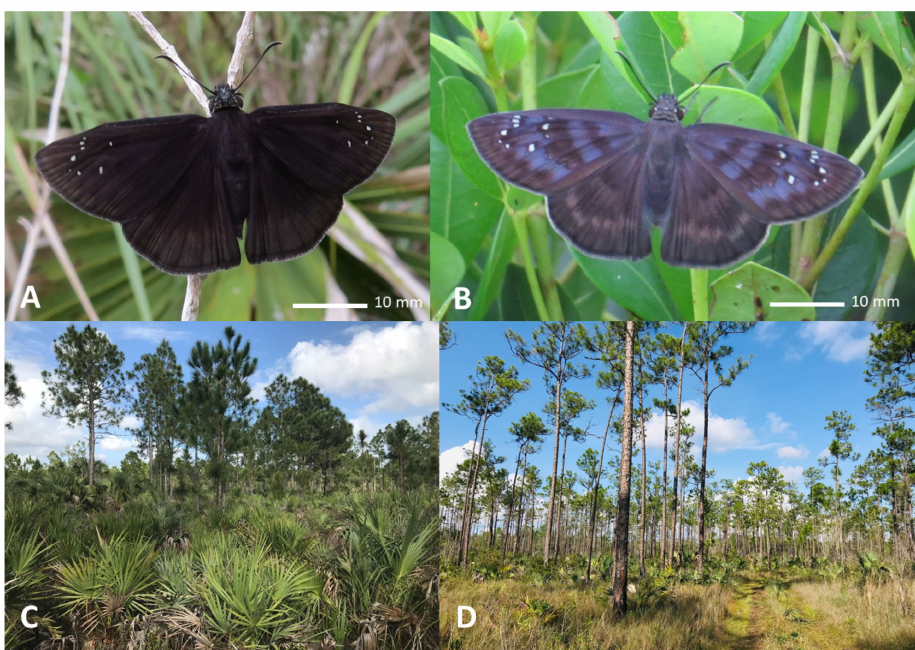
Figure 3. Adult male Florida duskywing ( E. brunnea floridensis ): ( A ) adult female Florida duskywing ( E. b. floridensis ); ( B ) Florida duskywing ( E. b. floridensis ): ( C ) pine rockland habitat at Zoo Miami (Miami-Dade County, Florida, USA); and ( D ) pine rockand habitat in Evergaldes National Park (Miami-Dade County, Florida,